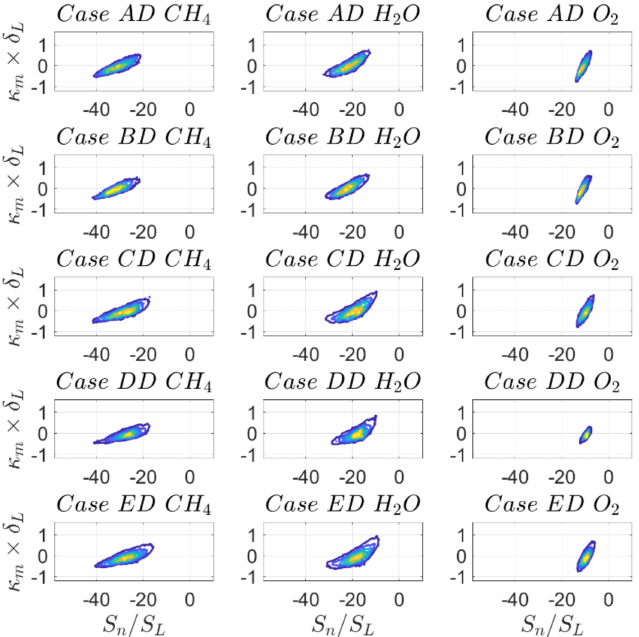
Figure A4. Joint PDF of normal diffusion component of displacement speed based on (1st to 3rd column) CH 4 , H 2 O,O 2 and normalised mean curvature κ m × δ L . All results are shown for c = 0.8 isosurface based on O 2 mass fraction, for top to bottom cases